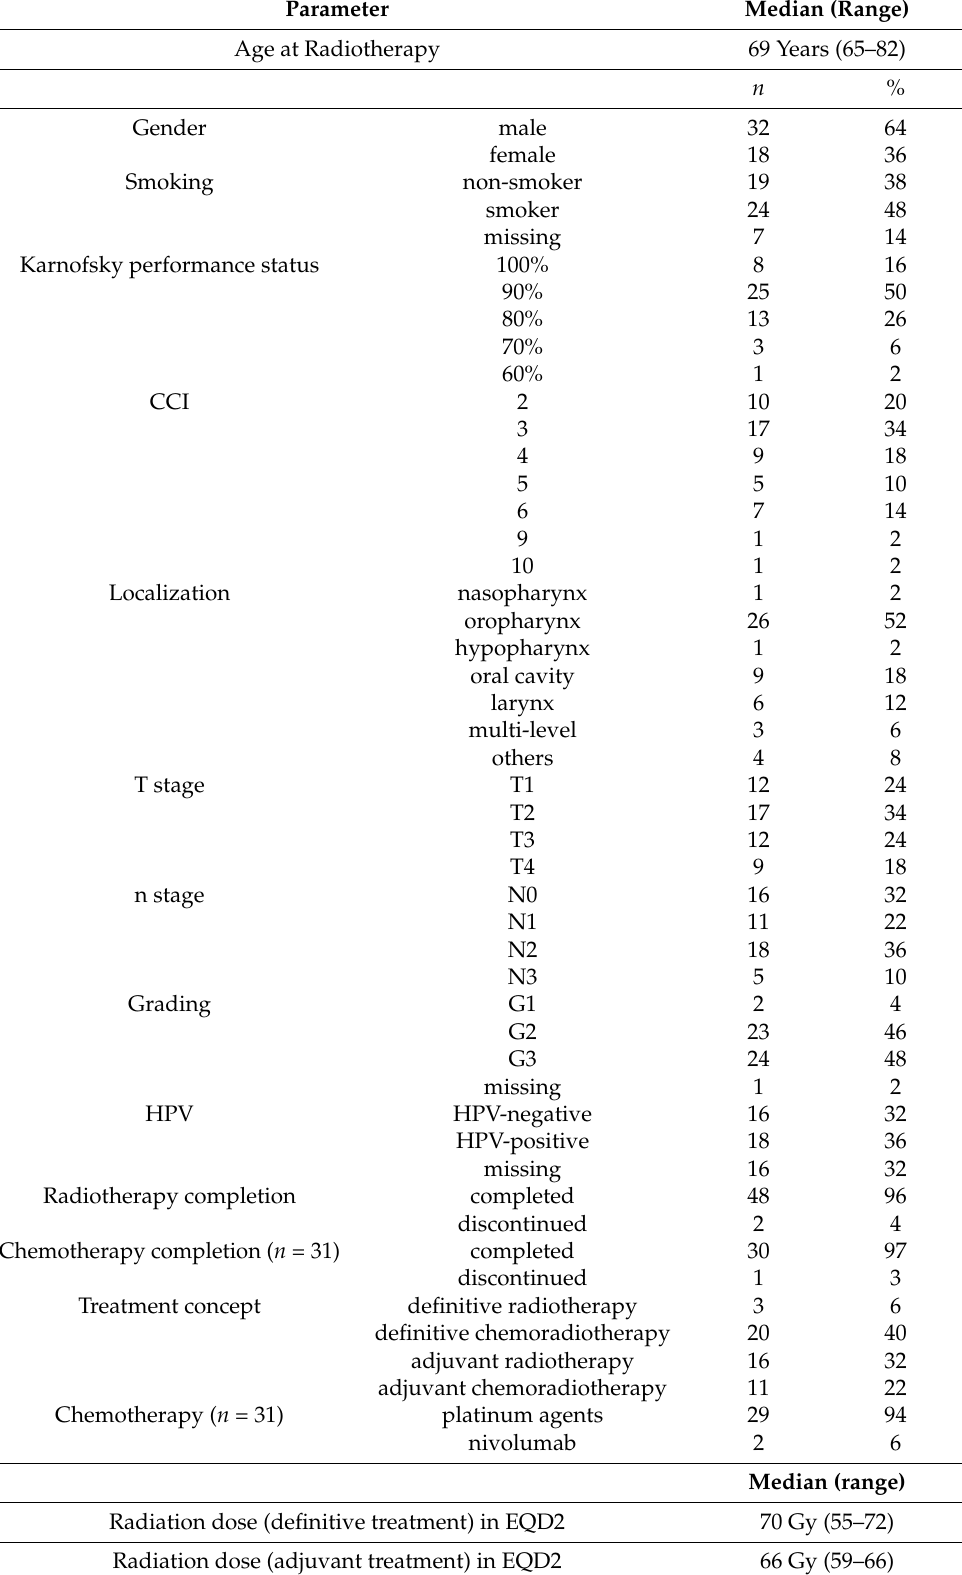
Table 3. Patient and treatment characteristics of the study cohort consisting of 50 elderly HNSCC patients treated by (chemo)radiotherapy in our institution between 2010 and 2019. CCI = Charlson Comorbidity Index, HPV = Human